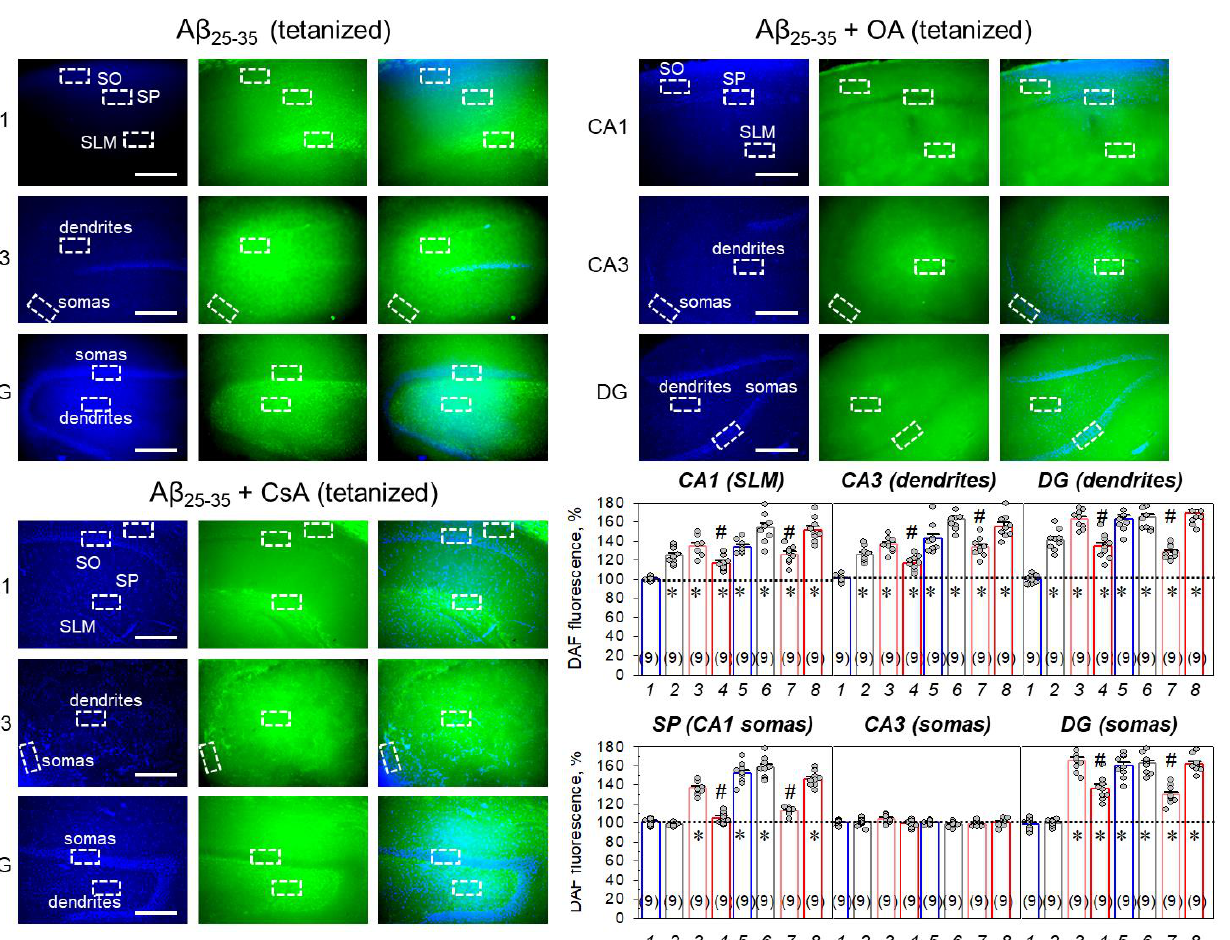
Figure 6. NO staining by DAF- FM dye in the Aβ 25-35 -treated hippocampal slices reveals a potent NO production in key hippocampal layers, such as CA1, stratum pyramidale (SP, arrows), stratum ra- diatum (SR), stratum lacunosum-moleculare (SLM), CA3, and dentate gyrus (DG). Blue fluores- cence channel indicates staining of cell nuclei by DAPI. Scale bars 300 μm. Right panels indicate curves for fluorescent channel profiles, corresponding to the lines in merged (Σ) channel. SO— stra- tum oriens.